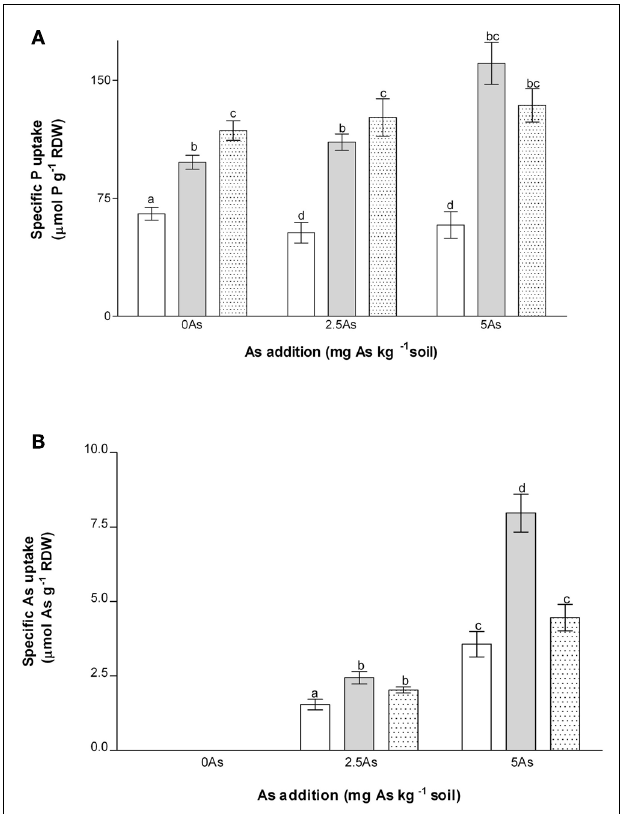
FIGURE 3 | Effects ofAs and inoculation on specific P uptake (A) and specificAs uptake (B) of non-mycorrhizal (open bars) and mycorrhizal ( G. intraradices , gray bars and G. mosseae , dotted bars) medic ( Medicago truncatula ) grown in pots with different phosphorus (P) levels, 10 and 20mgPkg − 1 soil (LP and HP, respectively) and with no arsenic (As) added to the soil (0As) or at rates of 2.5 and 5mgAskg − 1 soil (2.5As and 5As, respectively). Data are presented as mean values ± SEM ( n = 10, except for treatment group NM, 5 As where n = 8). For specific P uptake (A) the interactions between As and inoculation and between P and As were significant ( P = 0.001 and 0.002, respectively). For specific As uptake (B) the interaction between As and inoculation was significant ( P = 0.0001). In each panel the same letters indicate no significant difference between treatment groups at the 5% level.